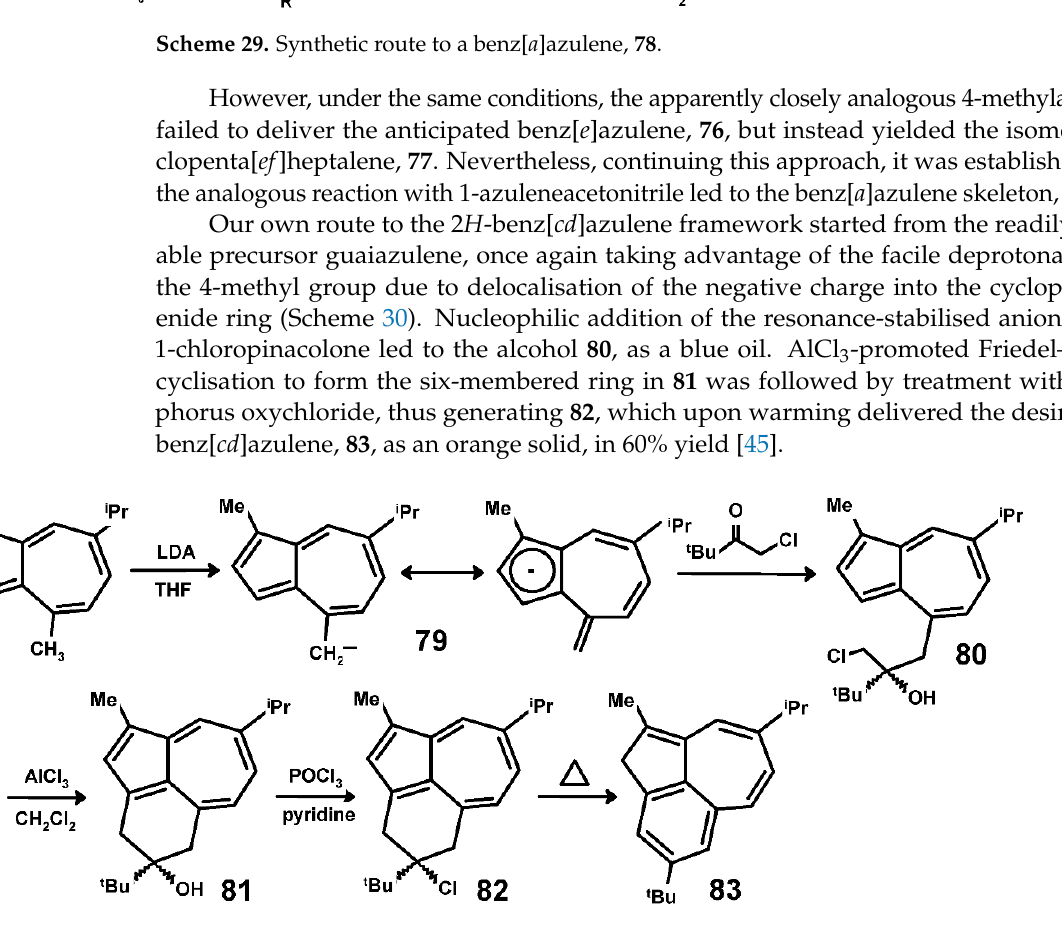
Figure 11. Molecular structure of the 2 H -benz[ cd ]azulene-chromium tricarbonyl complex, 85